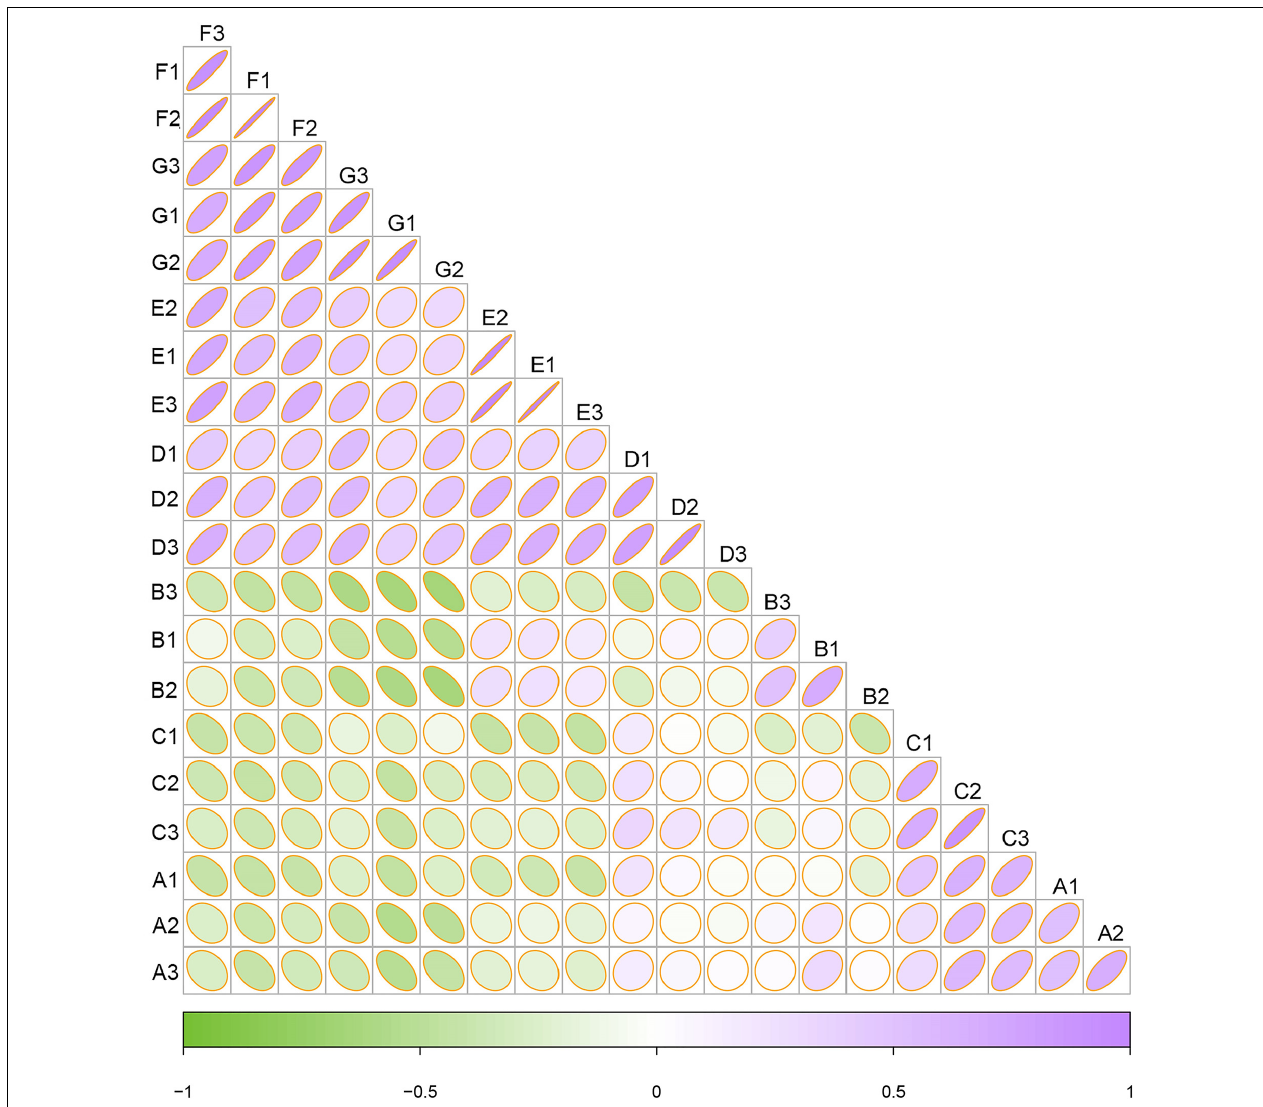
FIGURE 4 | Heatmap of fungal communities based on Bray–Curtis distance indices. Clustering of samples based on Bray–Curtis distance indices was calculated by ASVs at a distance of 3%. Color from green to purple indicated increased similarity. The radian of the fan corresponds to the correlation.